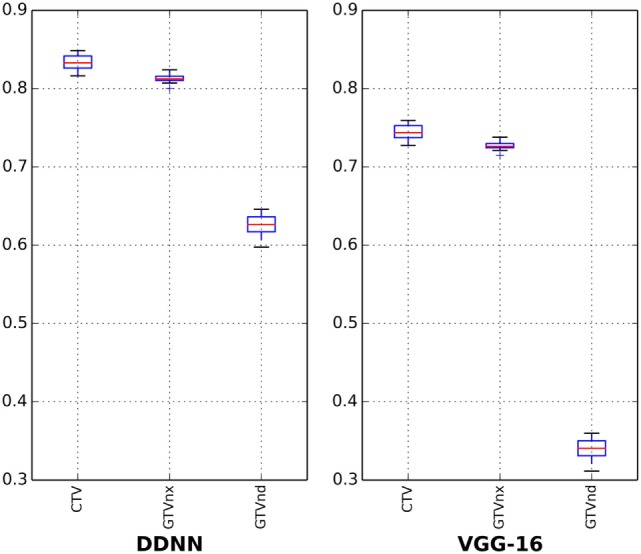
Boxplots obtained from Dice similarity coefficient analyses.